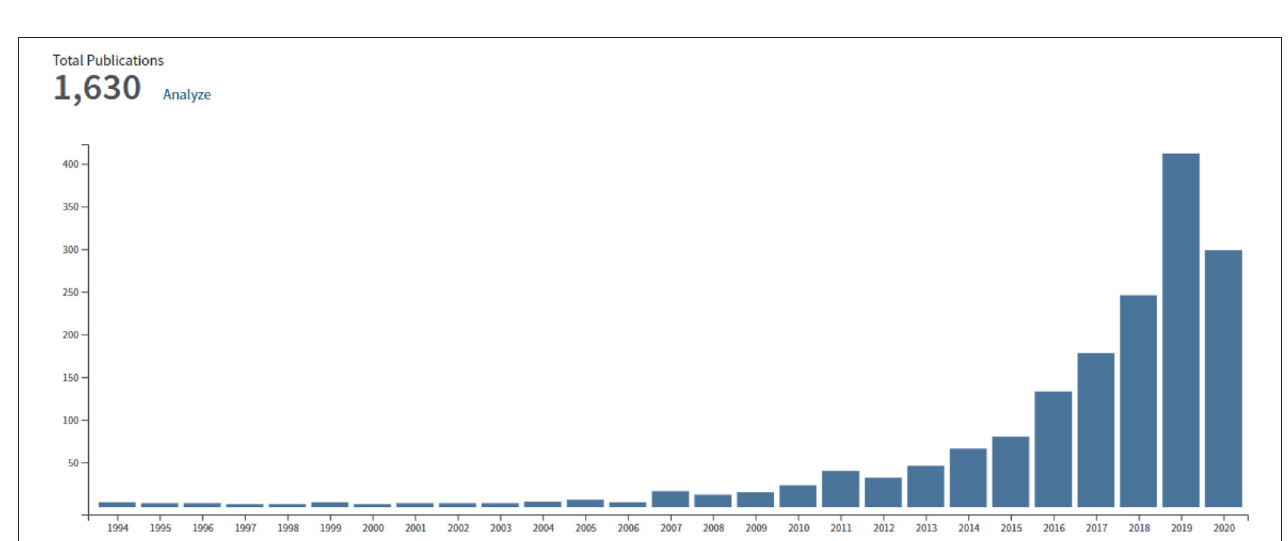
FIGURE 2 | Publication pattern for 1,630 publications on telemedicine in Arab countries through July 7, 2020.